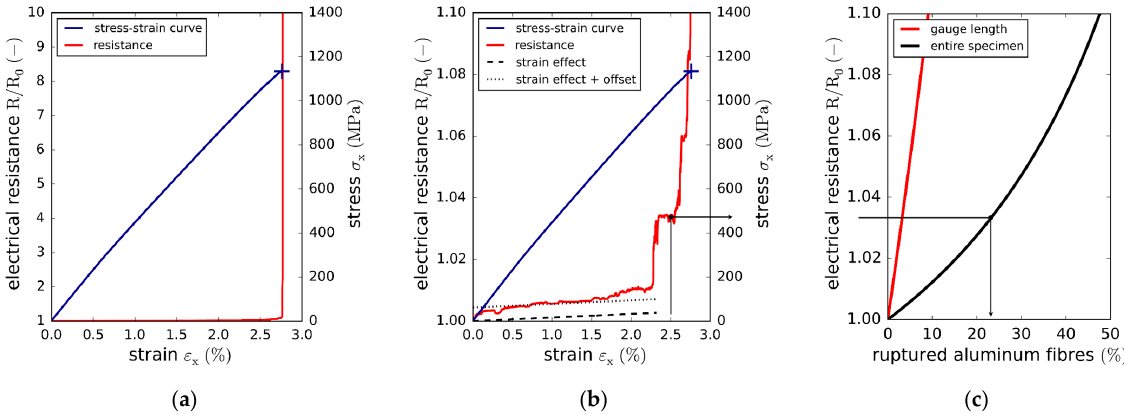
Figure 21. Exemplary resistance increase of a single specimen (potentiostatic measurements) during a quasi-static tension test ( a ), comparison with the estimated resistance increase due to strain ( b ), analytically calculated resistance increase due to the gradual rupture of the parallel non-touching aluminum fibers, according to Equation (7) ( c ).